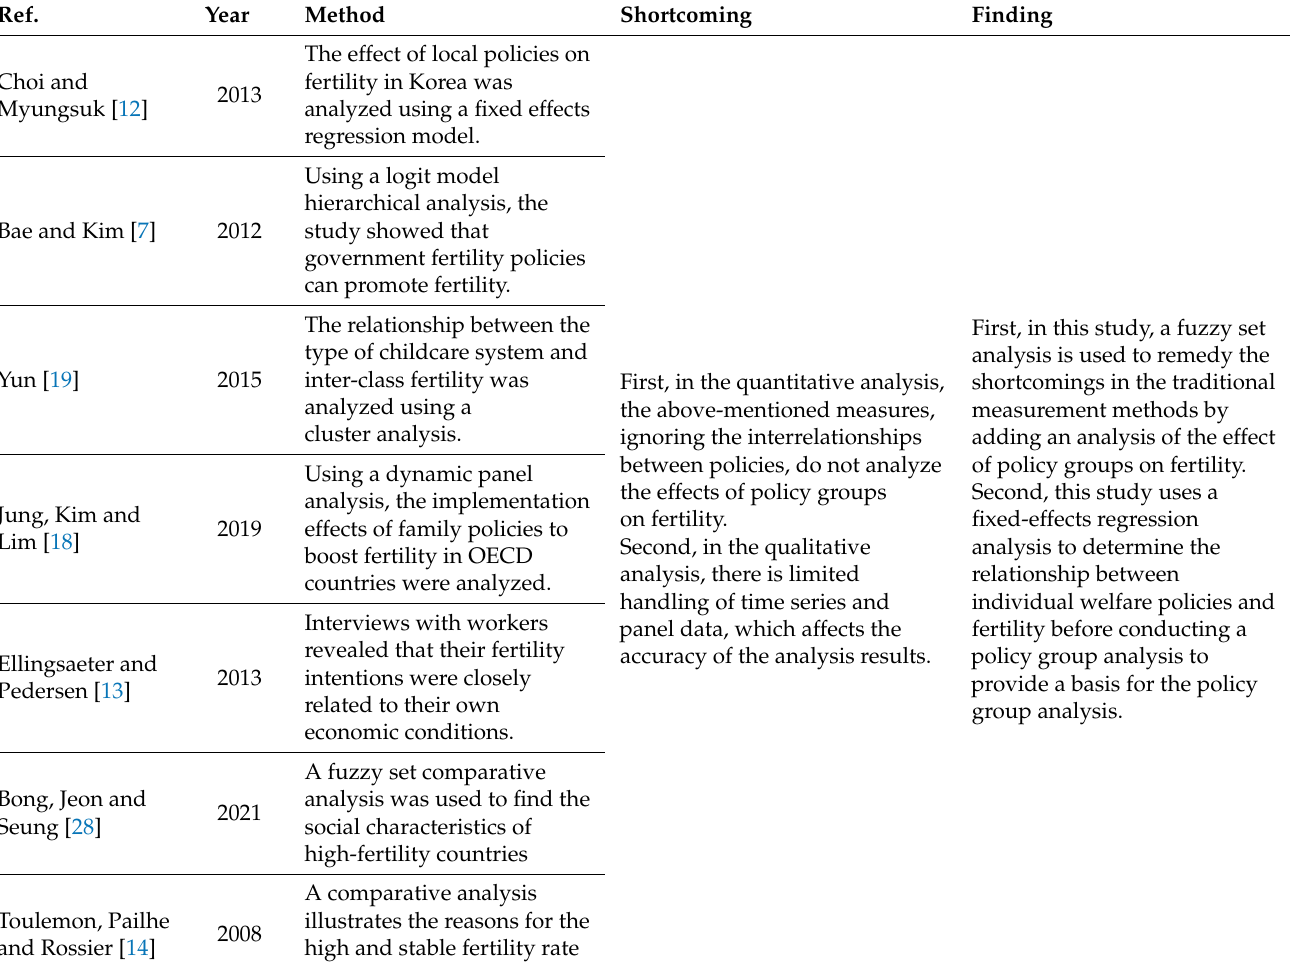
Table 1. A summary of the most relevant